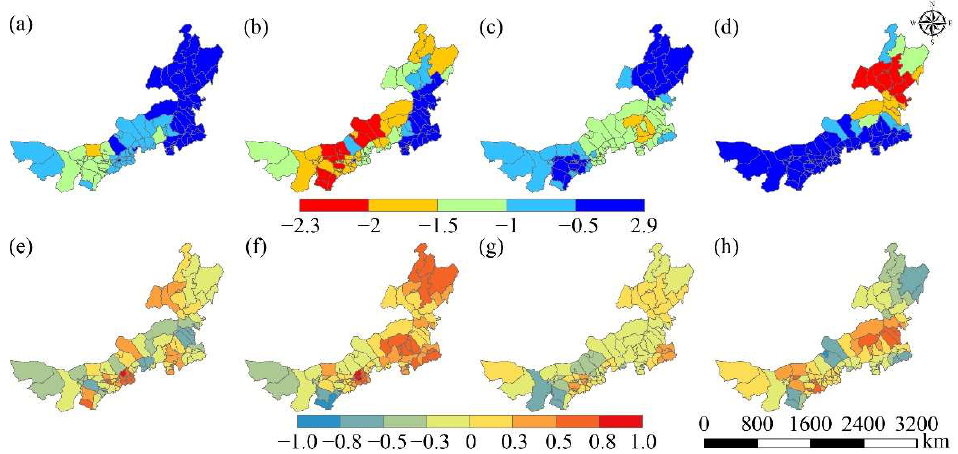
Figure 11. The distribution of SPEI in spring and summer of 2005, 2016 and the correlation between SPEI and large livestock population. ( a , b ) SPEI in spring and summer of 2005; ( c , d ) SPEI in spring and summer of 2016; ( e , f ) Correlation between SPEI and large livestock population in spring and summer of 2005; ( g , h ) Correlation between SPEI and large livestock population in spring and summer of 2016.